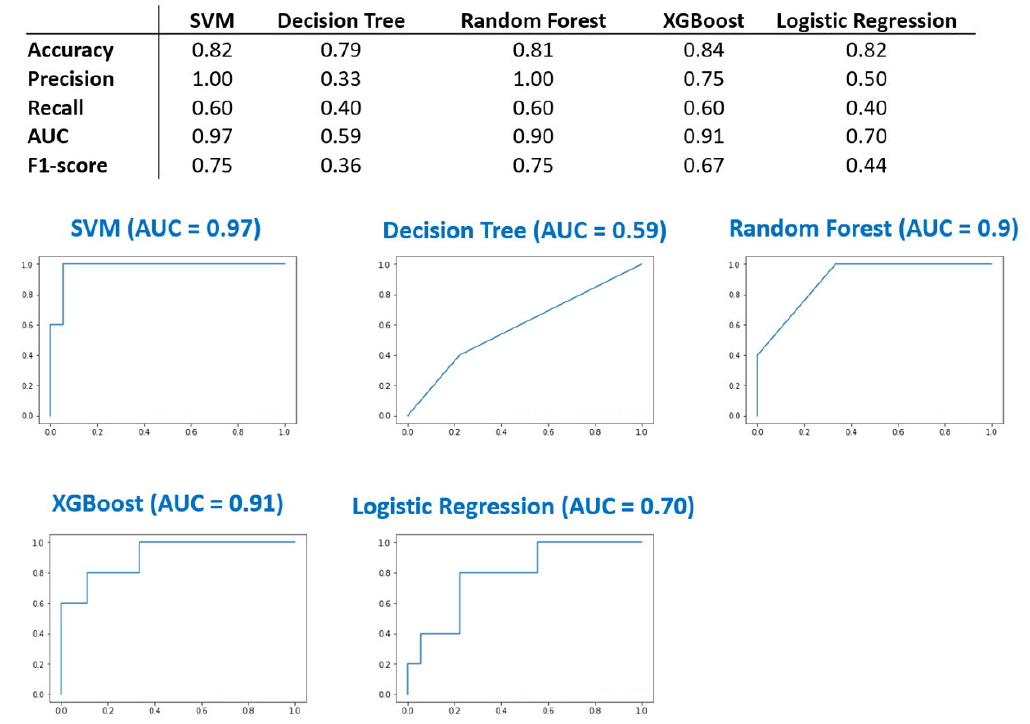
Figure 3. 27 SNP signatures were used to build predictive models via five different machine learning methods. Support Vector Machine (SVM), Random Forest, and XGBoost showed better performance of accuracy and area under the receiver operating characteristic (ROC) curve (AUC).